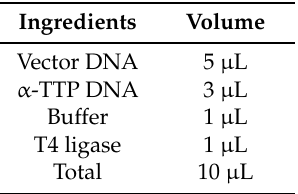
Table 3. Composition of the ligation reaction.